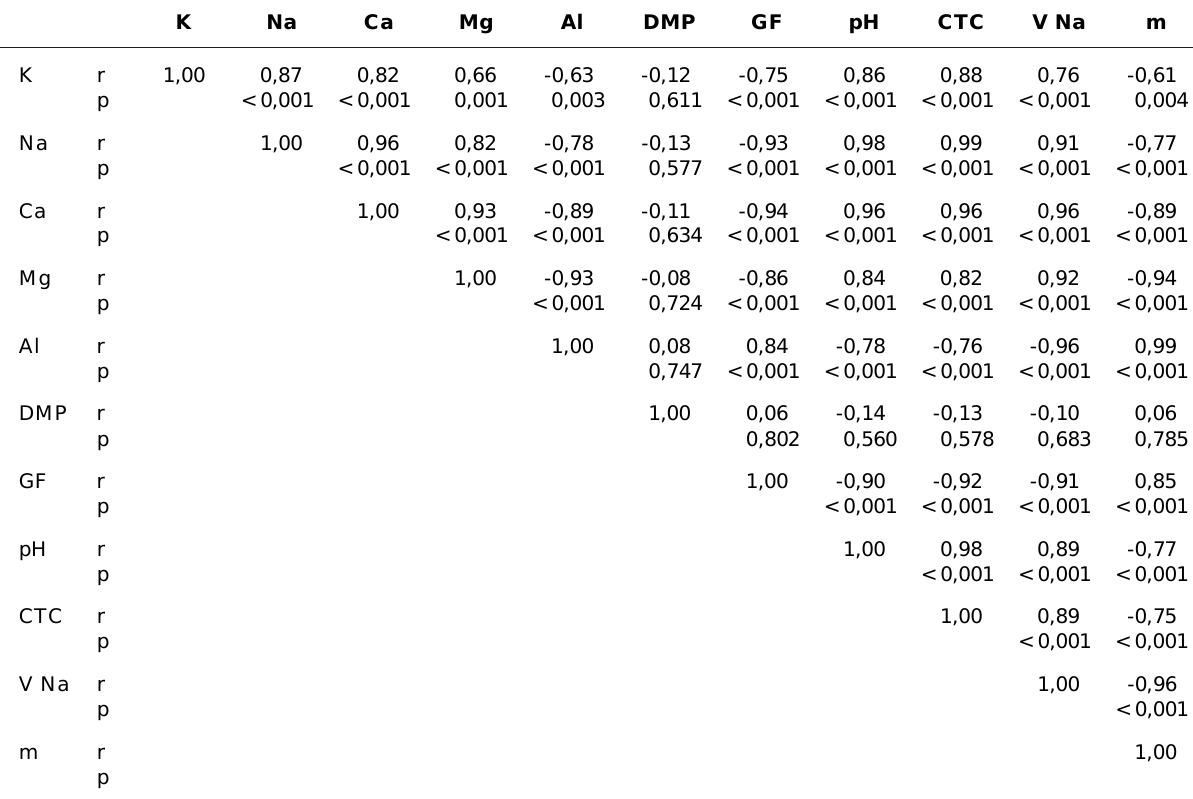
Quadro 3. Coeficientes de correlação de Pearson (r) e probabilidades (p) para potássio (K + ), sódio (Na +